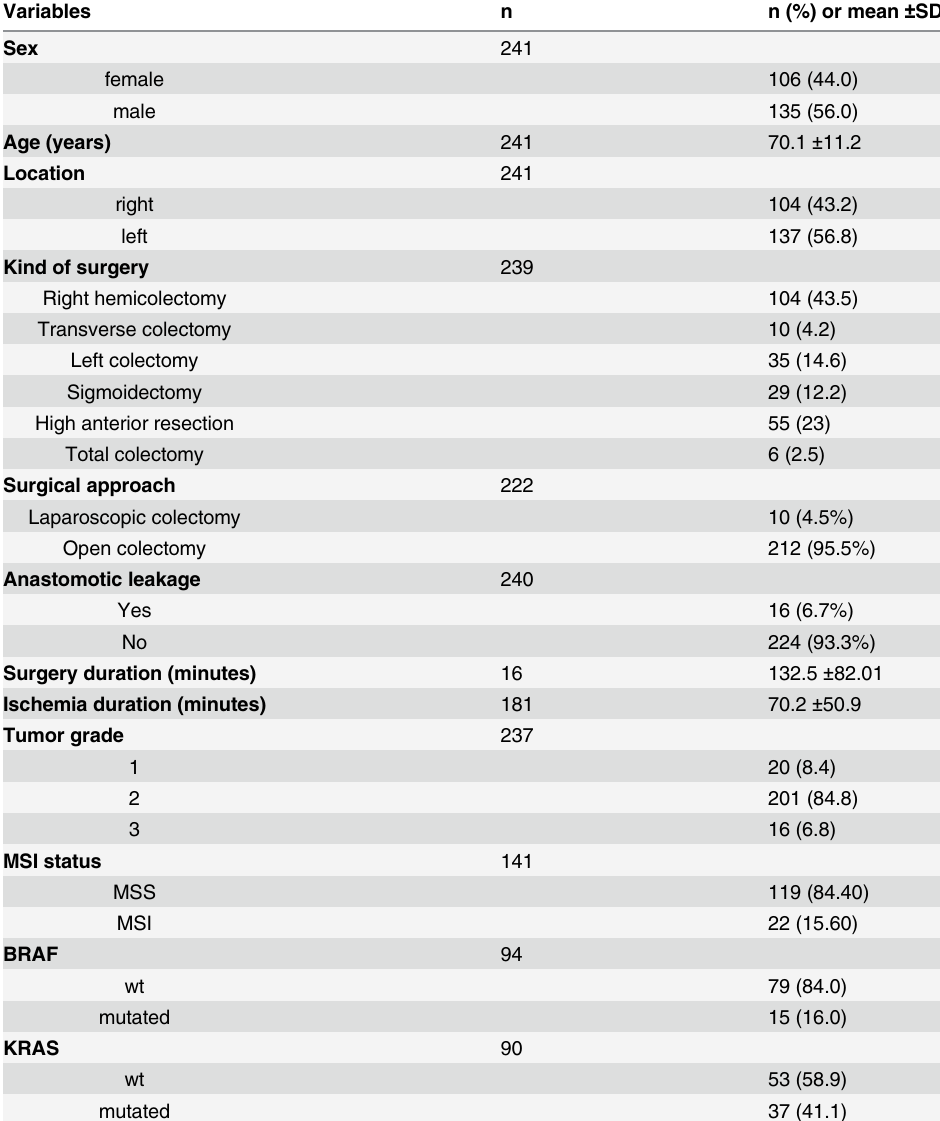
Table 1. Clinical, pathological and molecular available